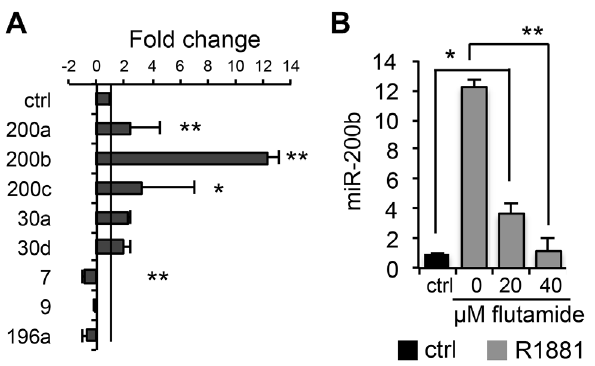
Figure 2. Validation of select miRNA. (A). MiRNA expression was normalized to that of control cells (ctrl). PC3-AR and control cells were treated 5 days with doxycycline to induce AR expression and with R1881 to induce AR activation and nuclear translocation and total RNA collected for analysis. The comparison is to untreated control and RNU1A_1 non-coding RNA is used as an internal control. The statistical significance of observed differences compared to control is * p # 0.05, and **p # 0.01 as was determined by one-tailed Student’s T-test. The average values are calculated for two independent experiments performed in triplicate. (B) AR activation upregulates miR-200b. PC3- AR cells (grey bars) were treated 5 days with both doxycycline to induce AR expression and with R1881 to induce AR activation and nuclear translocation. The comparison is to untreated control. Flutamide was added where indicated to block AR activity. Control (ctrl) PC3-AR cells were left untreated. RNU1A_1 non-coding RNA was used as an internal control. *, p , 0.05; **, p , 0.01 as determined by Students T-test. The average values were calculated for two independent experiments performed in